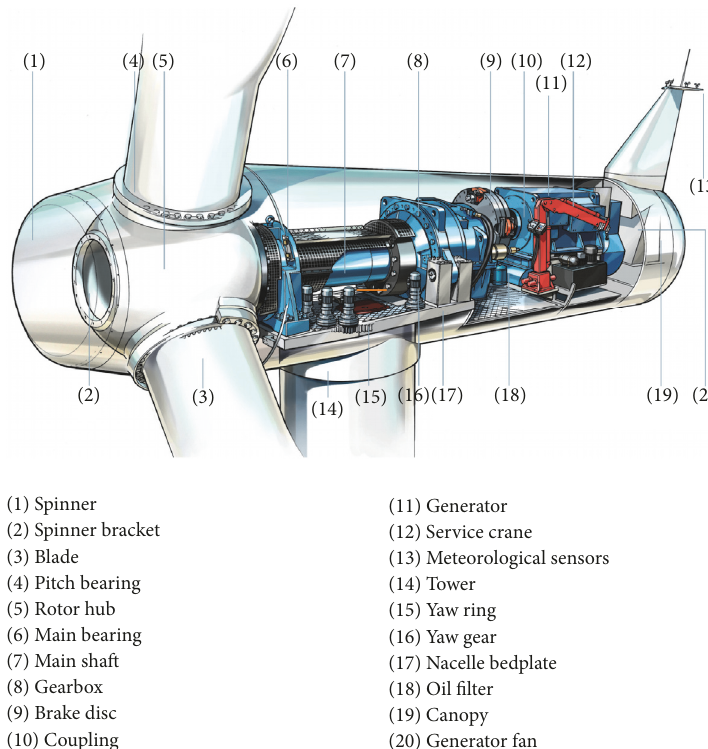
Figure 1: Nacelle arrangement (reference: Siemens